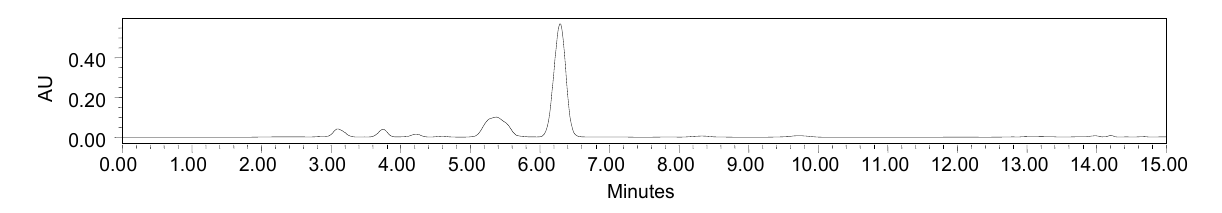
(313 K, 12.55 MPa); Figure 2. HPLC chromatograms of extracts: ( A ) SFE-CO 2 (333 K, 20.5 MPa); ( C ) Compressed propane (293 K, 15.0 MPa); ( B ) SFE-CO 2 ( D ) Compressed propane (313 K, 15.0 MPa); ( E ) Compressed propane (333 K, 15.0 MPa); ( F ) chloroform extract obtained by maceration. Chromatographic conditions: YMC Pack Pro C18 column; mobile phase: acetonitrile-water (58:42 v/v) with 1% acetic acid for 10 min, and 100% of acetonitrile from 11 to 15 min; flow rate 1 mL/min; temperature 298 K; detection 260